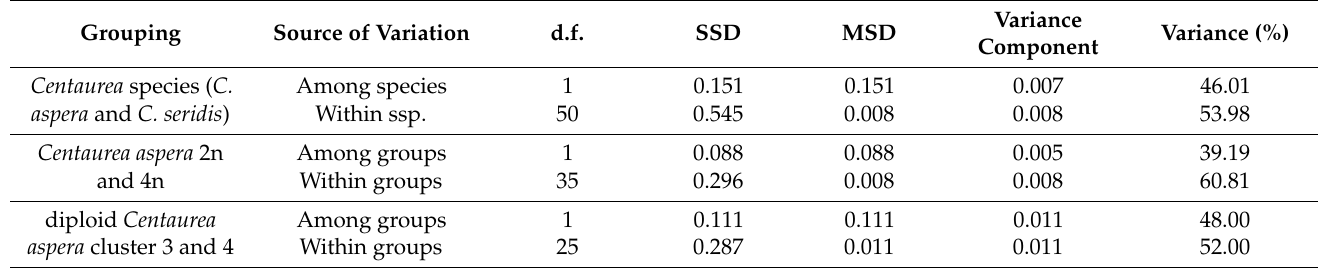
Table 2. Analyses of molecular variance (AMOVAs) in Centaurea aspera and C. seridis using a large SNP set. STRUCTURE analysis was used for establishing genetic